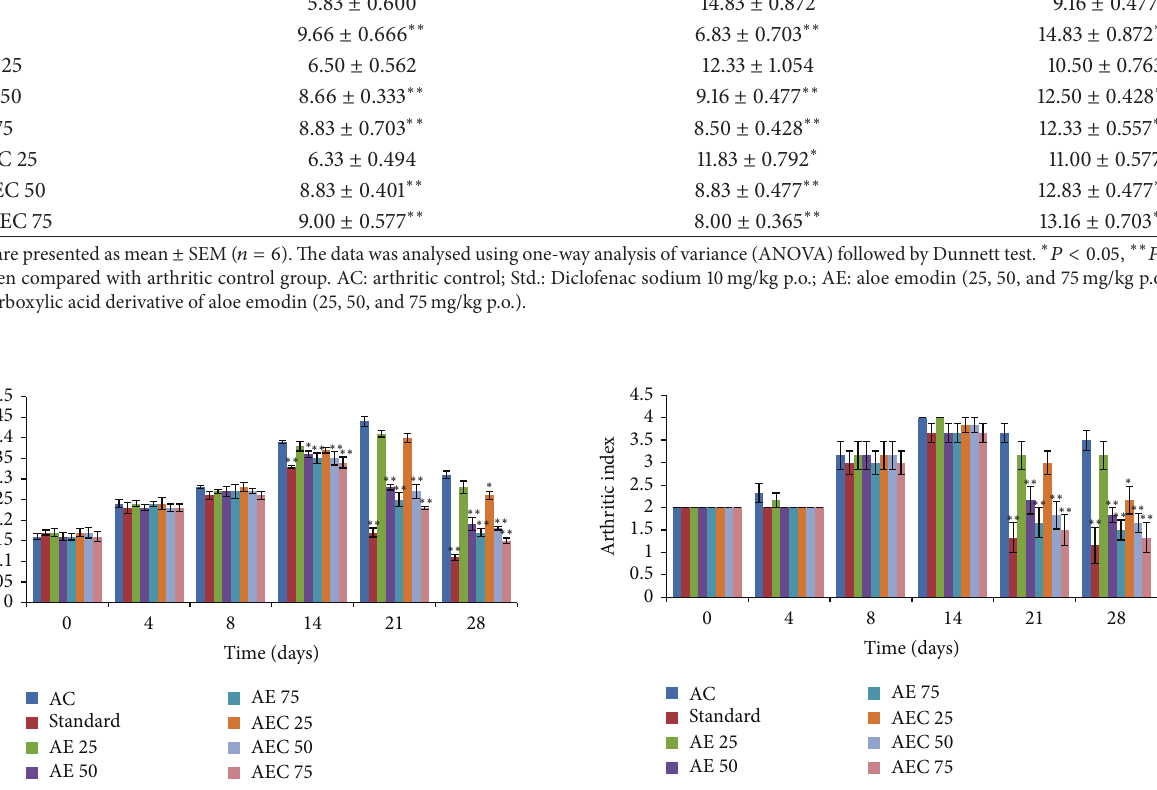
Table 5: Effect of AE and AEC on hematological parameters (RBCs, WBCs, and Hb) in Freund’s complete adjuvant induced arthritic rats. Groups ( 𝑛 = 6 )